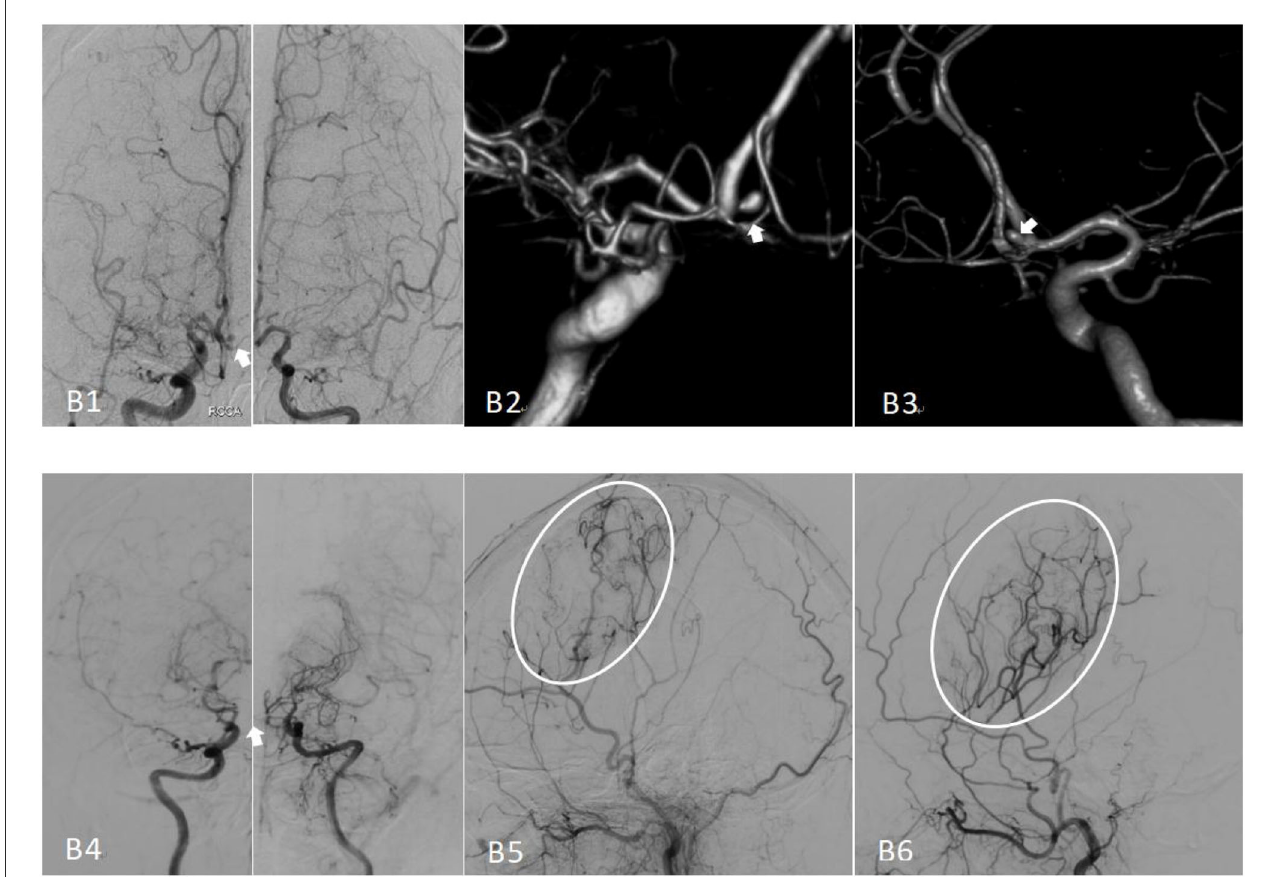
FIGURE2 Preoperative and postoperative cerebral angiography of moyamoya disease treated with encephaloduroarteriosynangiosis (EDAS). (B1) The bilateral preoperative internal carotid angiography (positive) image, with an anterior communicating artery aneurysm indicated by the white arrow. (B2, B3) Images of the preoperative angiography. (B4) The bilateral internal carotid angiography image, Suzuki stage II–V; note that the aneurysm has disappeared. (B5) An image of the right external carotid angiography (lateral) and vascular reconstruction. (B6) The postoperative left external carotid angiography (lateral)